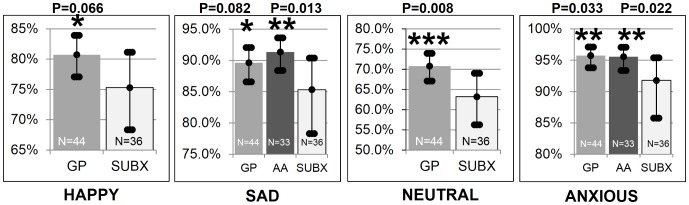
Significant differences in emotional self-awareness across groups.
Figure 10 shows that the SUBX patients tended to be less self-aware of happiness (75.3%; CI:68.4–81.1) than the GP group (p = 0.066) (78.8%; CI: 76.6–80.8); less self-aware of sadness (85.3%; CI:78.3–90.3) than AA members (p = 0.013) (91.3%; CI: 87.4–93.6) and tended to be less self-aware of sadness than the GP (p = 0.082) (89.6%; CI: 87.8–91.2); less self-aware of their neutral state (63.2%; CI:57.0–69.0) than the GP (p = 0.008) (70.7%; CI:67.3–74.0) and AA members (p = 0.022) (71.7%; CI: 68.9–74.3); and less self-aware of their anxiety (91.8%; CI: 85.8–95.4) than the GP (p = 0.033) (95.8%; CI:93.4–97.1) and AA members (p = 0.022) (95.6%; CI:93.4–97.1).